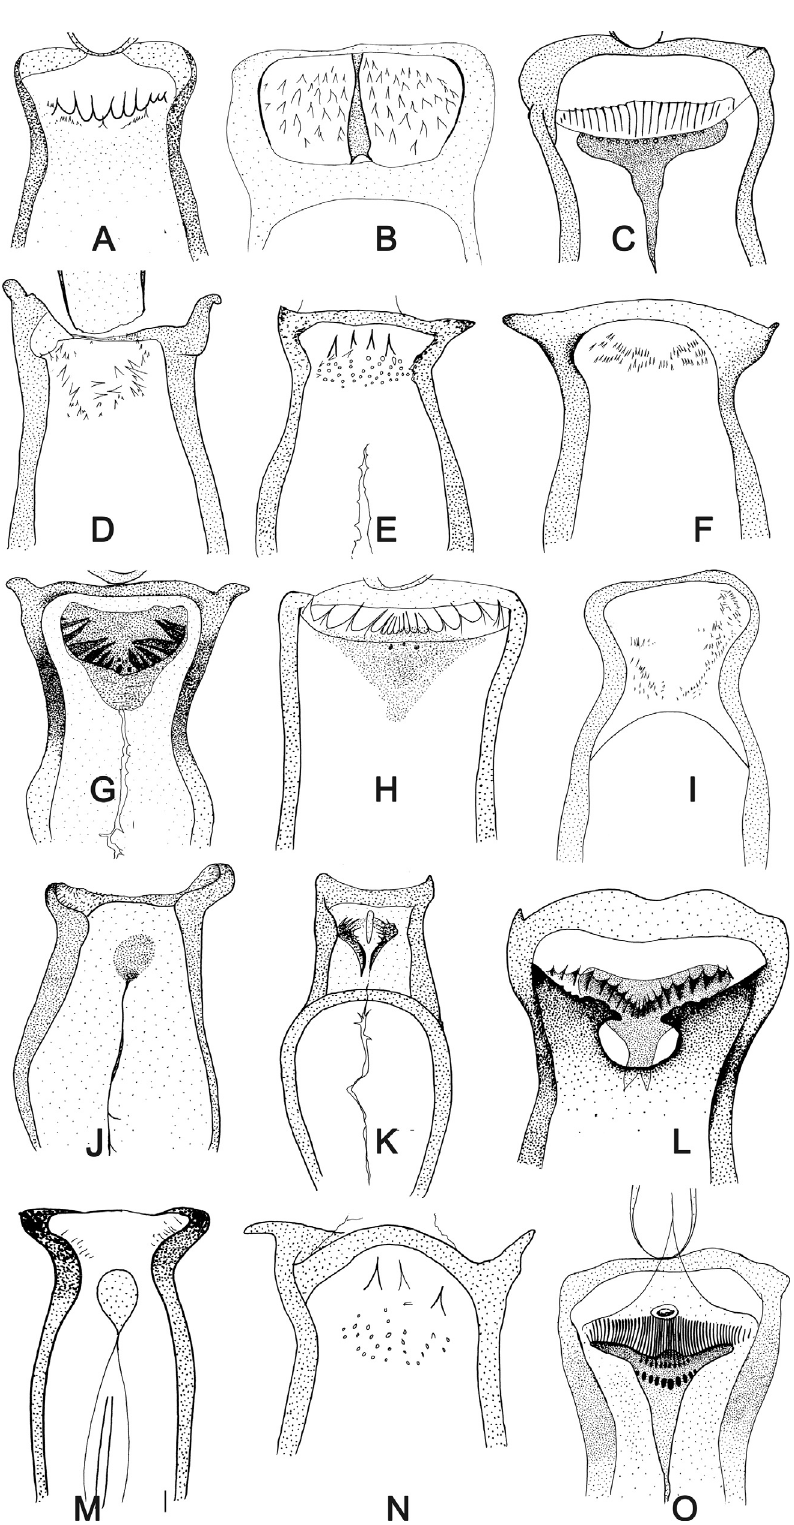
Figure 9. Cibarium of phlebotomine females. (A) Australophlebotomus notteghemae ; (B) Idiophlebotomus padillarum ; (C) Sergentomyia ( Vattieromyia ) sclerosiphon ; (D) Phlebotomus ( Euphlebotomus ) mascomai ; (E) Phlebotomus ( Madaphlebotomus ) vaomalalae ; (F) Sergentomyia bailyi ; (G) Sergentomyia ( Sergentomyia ) phadangensis ; (H) Sergentomyia hivernus ; (I) Phlebotomus ( Transphlebotomus ) anatolicus ; (J) Chinius eunicegalatiae ; (K) Chinius samarensis ; (L) Sergentomyia ( Parrotomyia ) babu ; (M) Parvidens heishi ; (N) Phlebotomus ( Madaphlebotomus ) vincenti ; (O) Sergentomyia ( Vattieromyia )